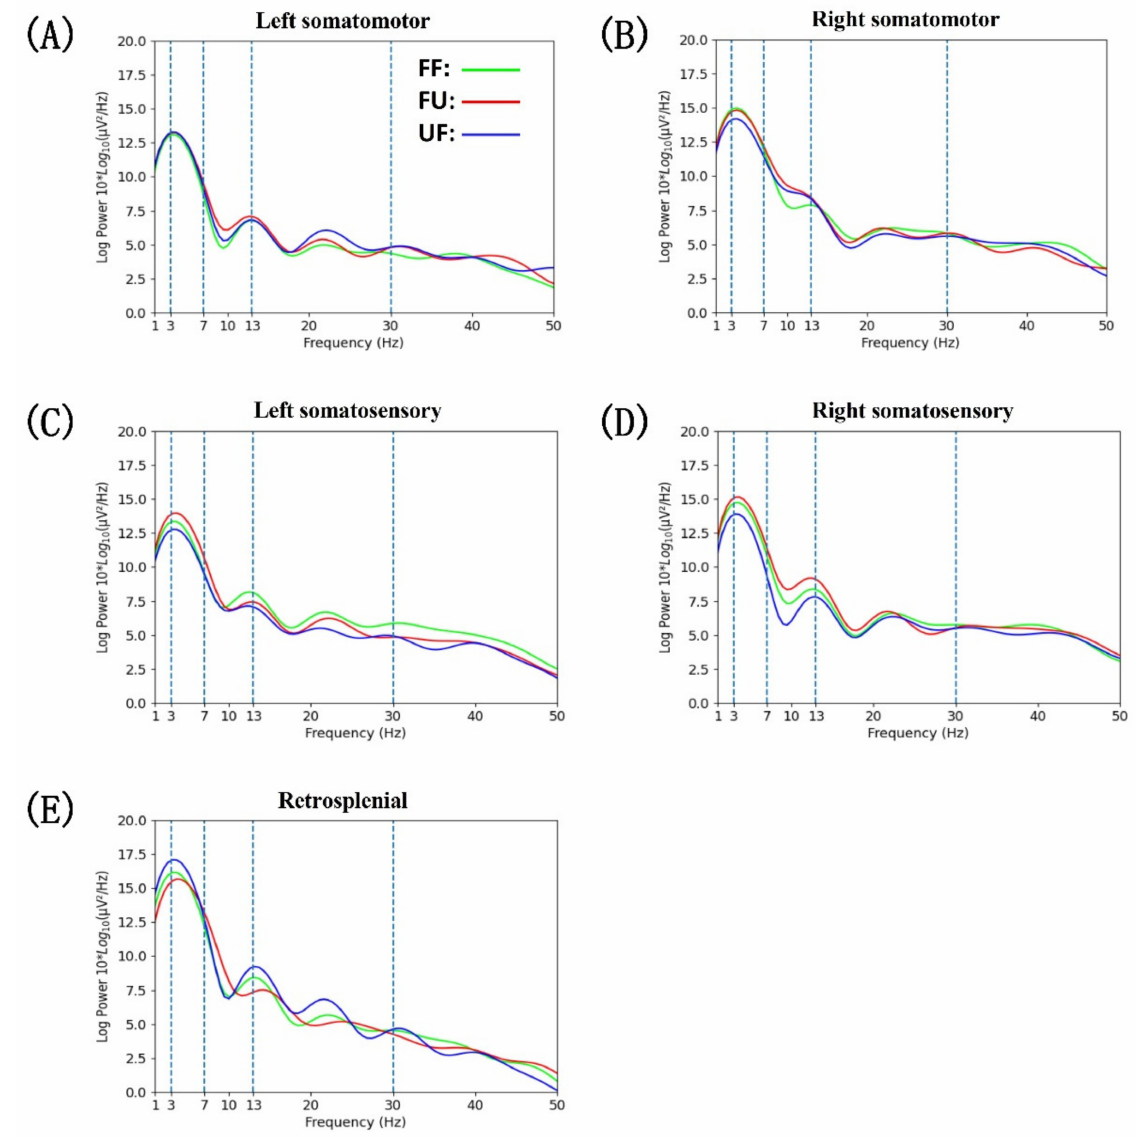
Figure 6. ( A – E ) Average power spectral density by cluster for the three experimental walking conditions. (1) FF (green line); (2) FU (red line); and (3) UF (blue